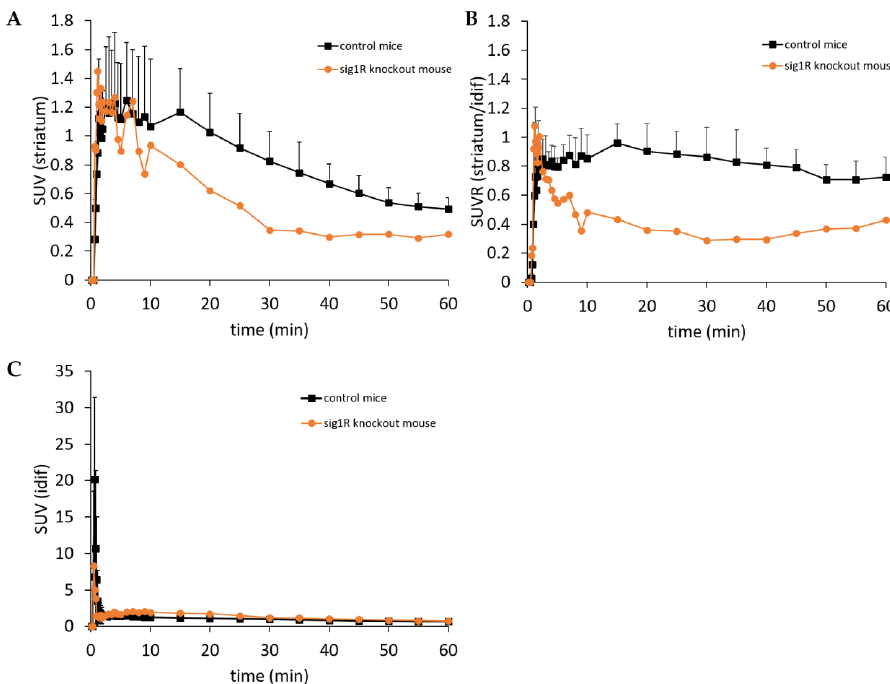
Figure 3. Positron Emission Tomography / Magnetic Resonance (PET / MR) imaging of control mice ( n = 3) and of sig1R-knockout mouse ( n = 1) after i.v. administration of ( S )-( − )-[ 18 F]fluspidine. ( A ) Average striatal time-activity curves for control mice (black squares) and sig1R-knockout mouse (orange dots). ( B ) Average time-varying SUVRs of the striatum over the blood (defined from the image-derived input function (idif)) of control mice (black squares) and sig1R-knockout mouse (orange dots) ( C ) Average time-varying SUV of the blood (defined from the idif) of control mice (black squares) and sig1R-knockout mouse (orange